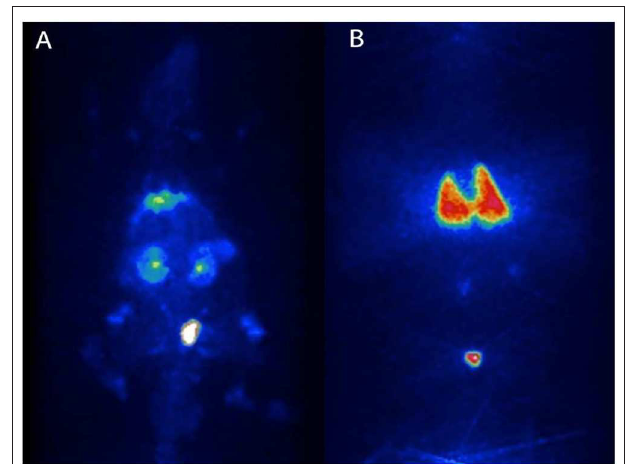
FIGURE 1 | Migration pattern of i.a and i.v. infused human DSCs in the rat. Naïve Sprague-Dawley rats received intra-aortal (i.a) injections ( n = 2) and tail-vein (i.v) injections ( n = 2) with 1 × 10 6 DSCs labeled with [2- 18 F]-2-fluoro-2-deoxy-D-glucose ( 18 F-FDG). Dynamic in-vivo positron emission tomography of cell trafficking was done immediately after injection. (A,B) , are cell distribution patterns following i.a and i.v infusion of DSC,